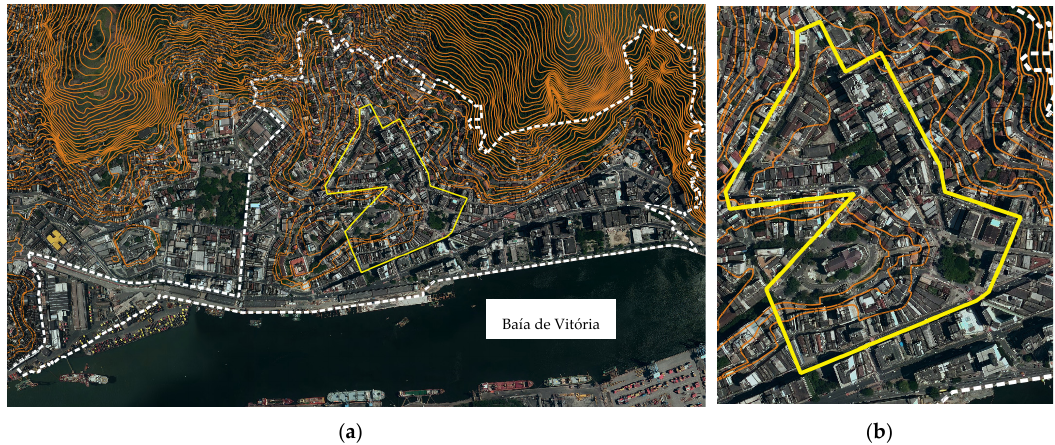
Figure 3. ( a ) Center neighborhood delineation (white dash); ( b ) highlighting the study area in the historic center of Vitória, Brazil (yellow). Source: created by the authors in July 2021, based on GeoWeb/PMV cartography [55].